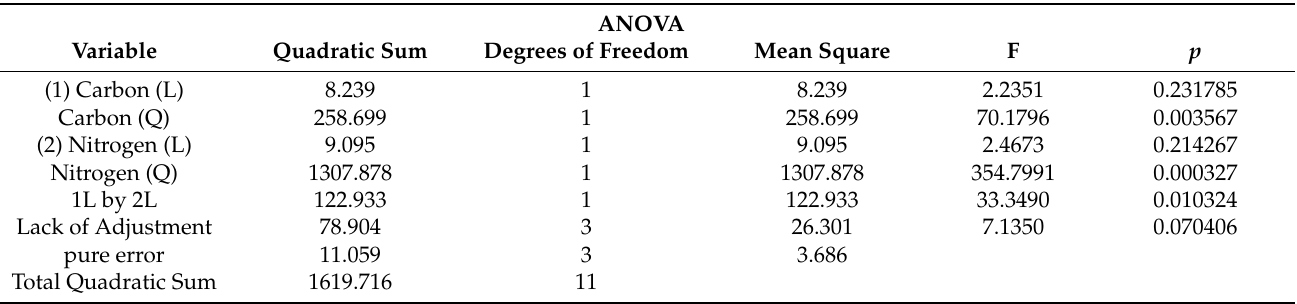
Figure 1. Pareto diagram and estimated effects of carbon and nitrogen sources on production of RL by P. aeruginosa LBI 2A1 in 96 h of fermentation. Linear terms associated with letter L and quadratic terms with letter Q. Values considered absolute. 1L by 2L indicates interaction between factors. Table 3. Analysis of variance (ANOVA) for production of RL by P. aeruginosa LBI 2A1 using central composite rotational